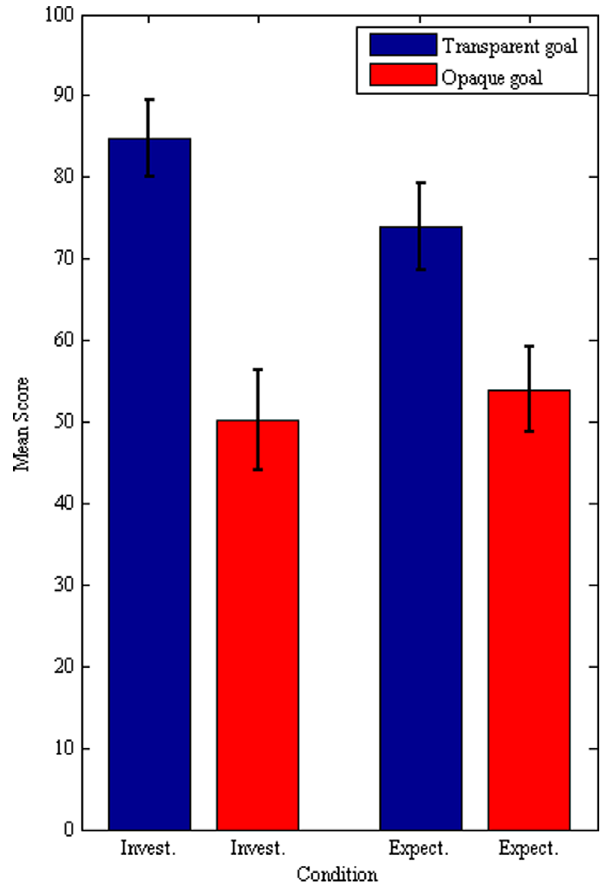
Figure 3. Investments and expectations in the public goods game. Each observation represents the amount invested or expected to be invested. Participants in the transparent condition show significantly higher investment levels, and subsequently higher expectations about the investment of the other player (n=48).